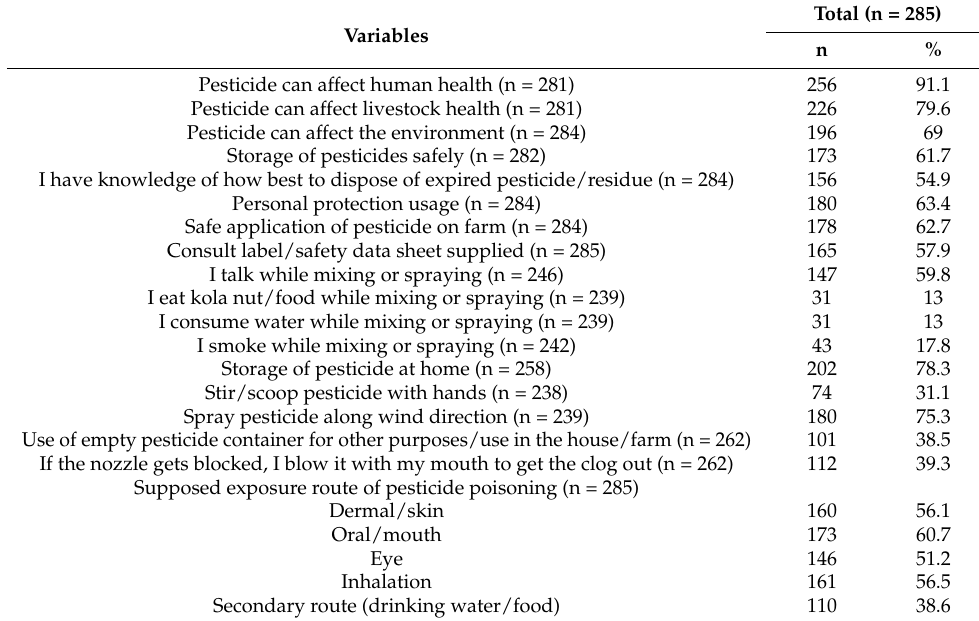
Table 5. Respondents’ awareness of pesticide safety and route of